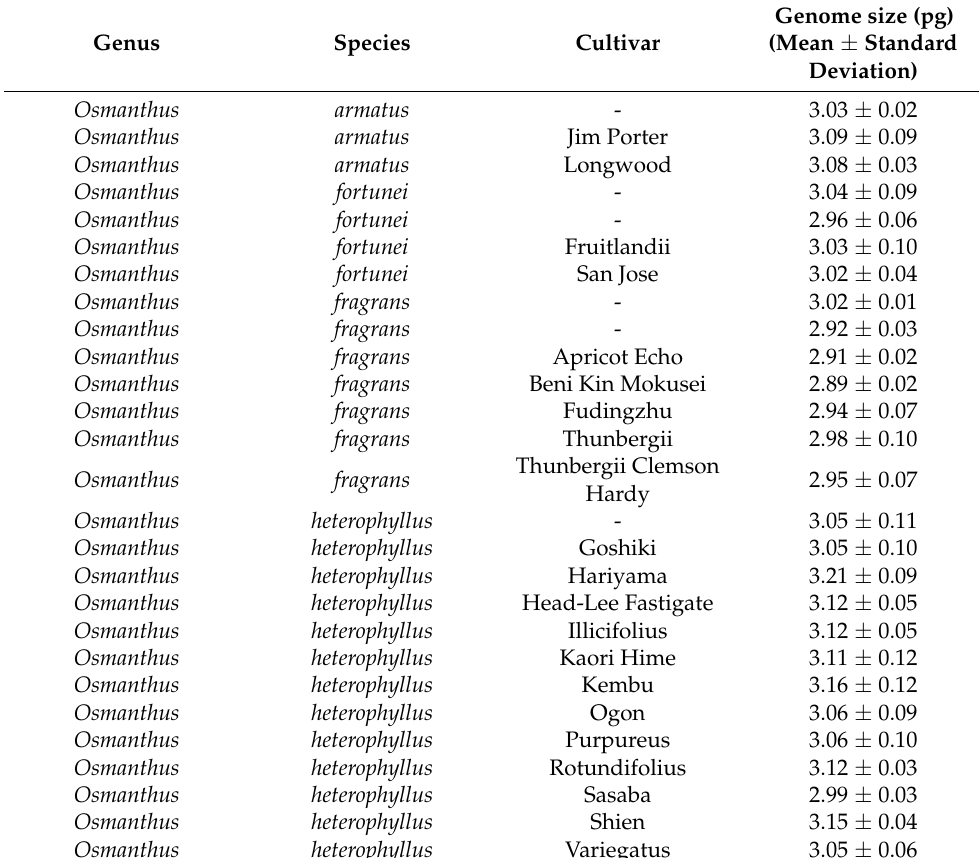
Table 2. Genome size of twenty-seven Osmanthus accessions. A dash (-) represents an unnamed seedling.